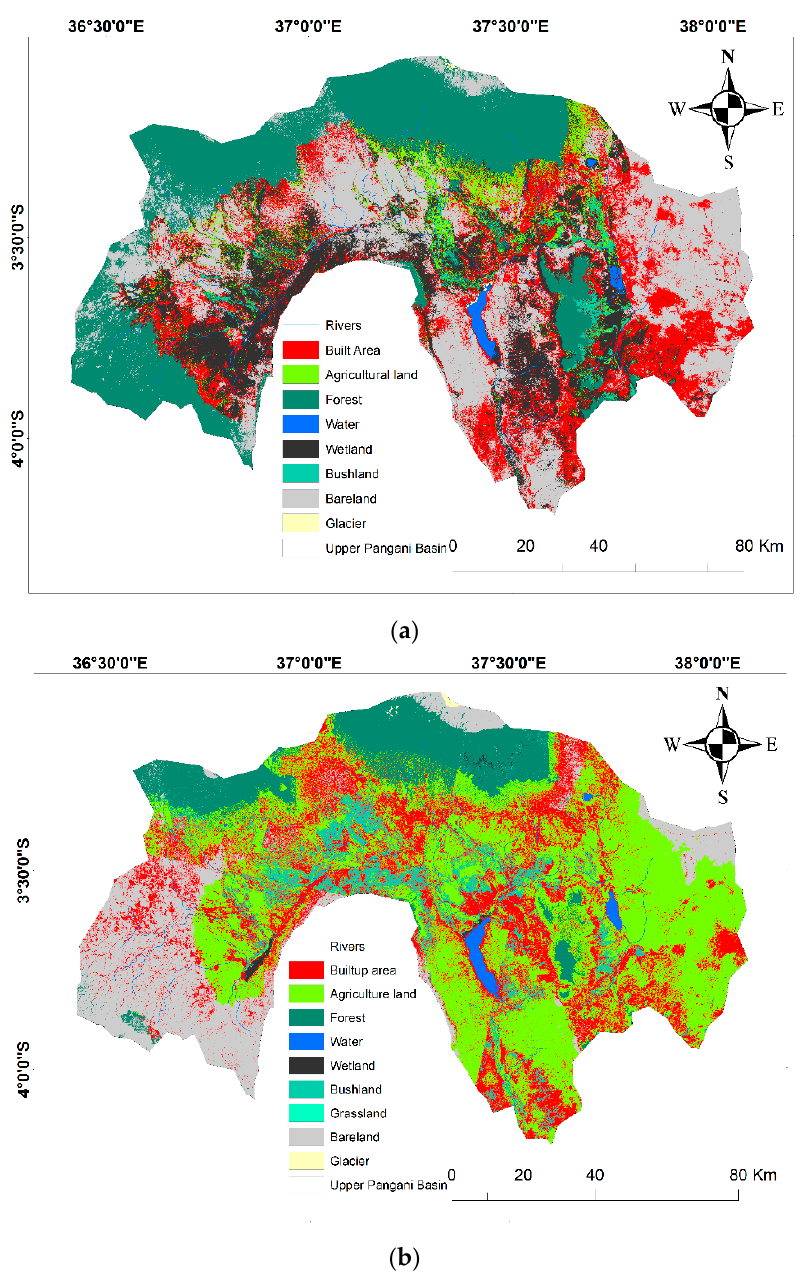
Figure 2. Land cover maps derived from Landsat imagery of ( a ) 1987 and ( b ) 2018, respectively detailing the changes in land use land cover from 1987 to 2018.